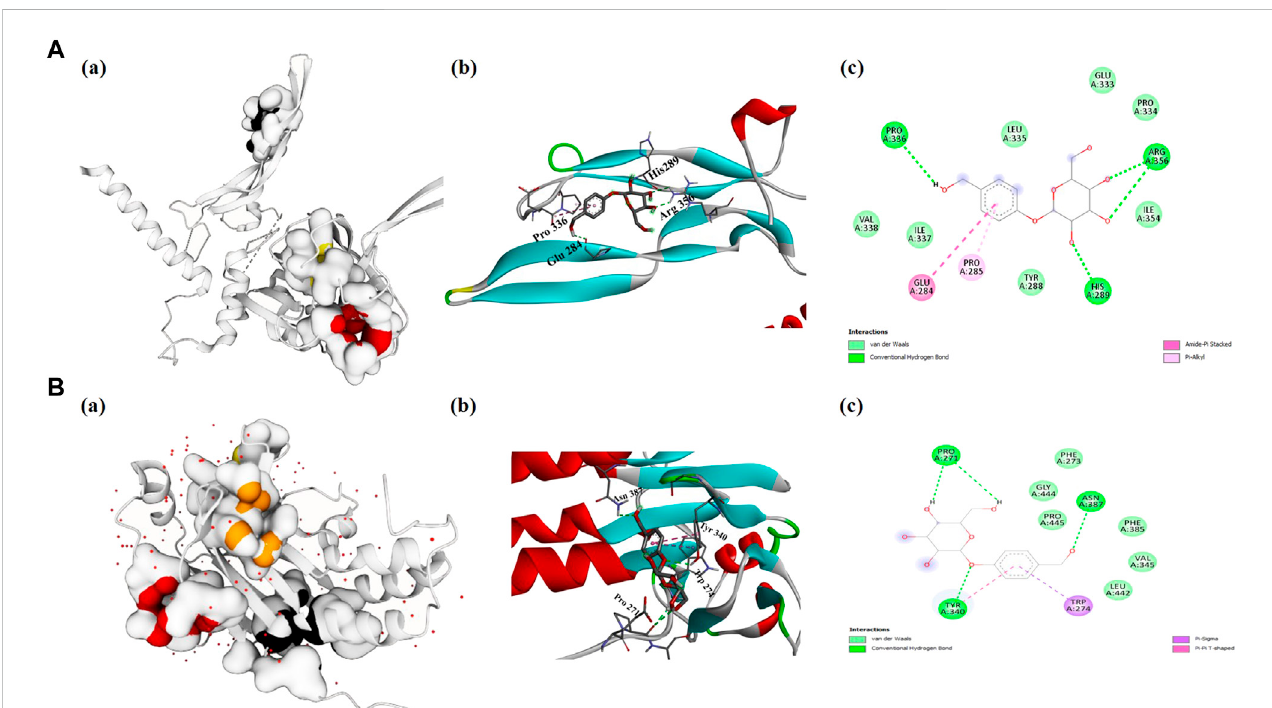
FIGURE 5 Evaluation of molecular docking studies. Representation of protein-ligand complex interaction (A) TGF- β 1 (A) shows the prediction of pocket sites (B) docking of gastrodin-TGF- β 1 receptor and (C) 2D-interacting residues ofTGF- β 1 to gastrodin molecule (B) SMAD2 (A) represents the pocket sites (B) docked representation of gastrodin-SMAD2 receptor and (C) 2D-interaction of SMAD2 amino acids with